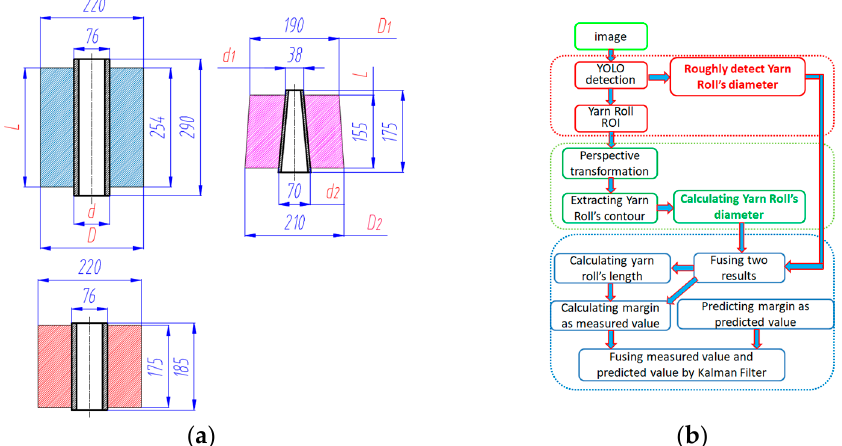
Figure 2. Yarn roll’s type and algorithm flow. ( a ) Yarn roll’s type and size. ( b ) Algorithm flow.